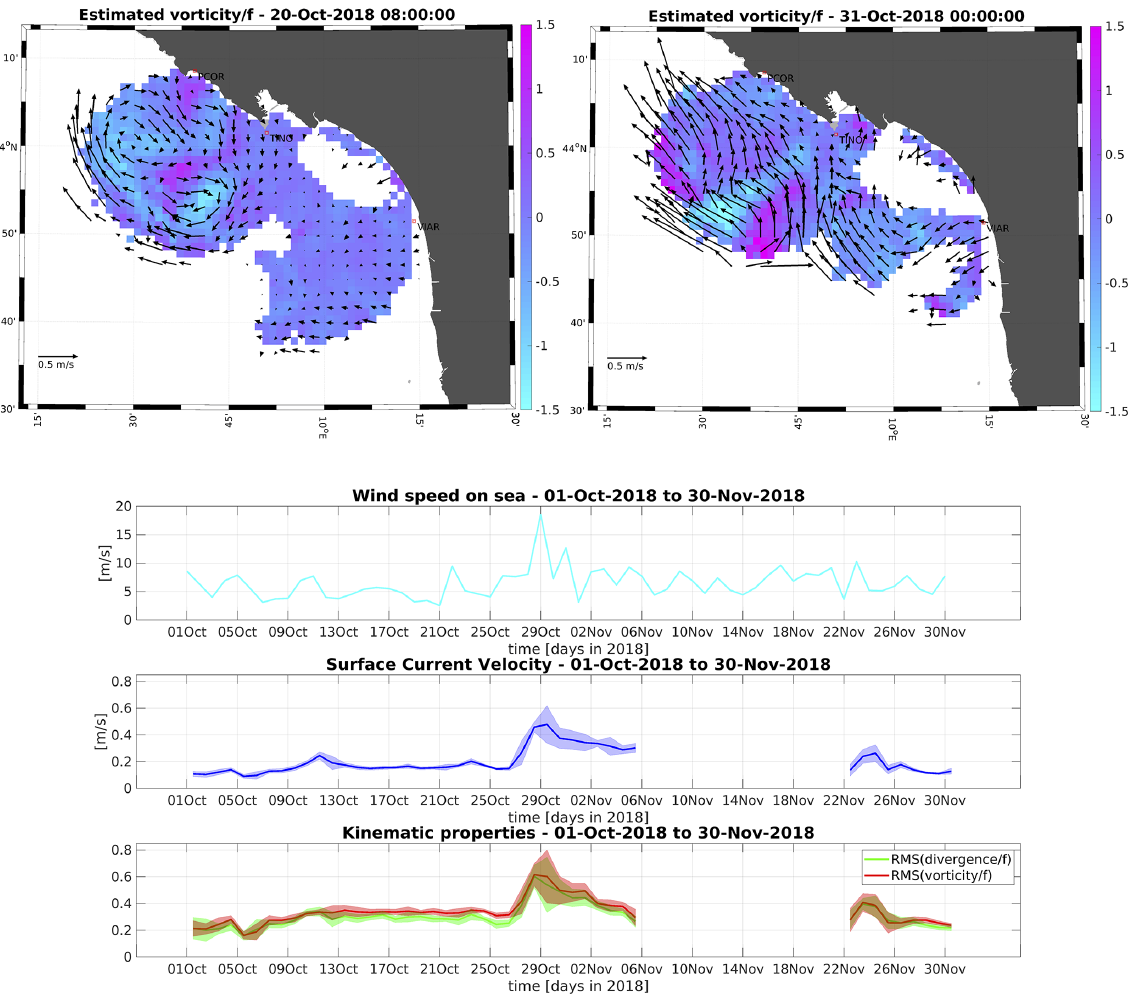
Figure 7. From top to bottom: example map of normalized vorticity before and during the extreme event. Time series of wind speed, surface current magnitude, and root mean square of normalized vorticity and divergence. Original source: from Berta et al.